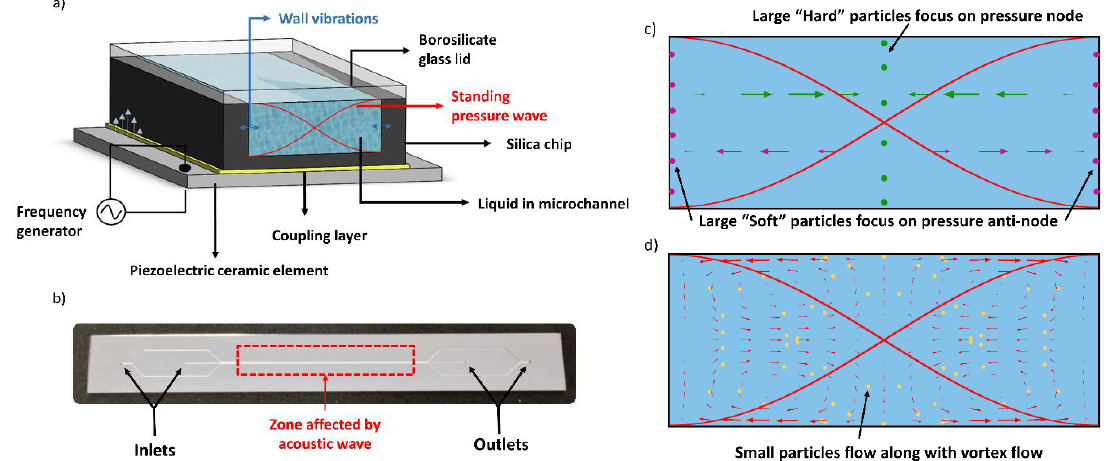
Figure 1. ( a ) Schematic representation of an acoustofluidic channel: A piezoceramic element is vibrating at 1.93 MHz. Vibrations are transferred to the channel wall, creating a standing pressure wave. ( b ) Picture of an acoustofluidic chip, showing two inlets and two outlets together with the acoustic zone. ( c ) The behavior of large particles (>2 µ m) in an acoustofluidic device. “Hard” particles focus on the pressure node while “soft” particles focus on the pressure antinodes. ( d ) The behavior of small particles (<2 µ m) in an acoustofluidic device.